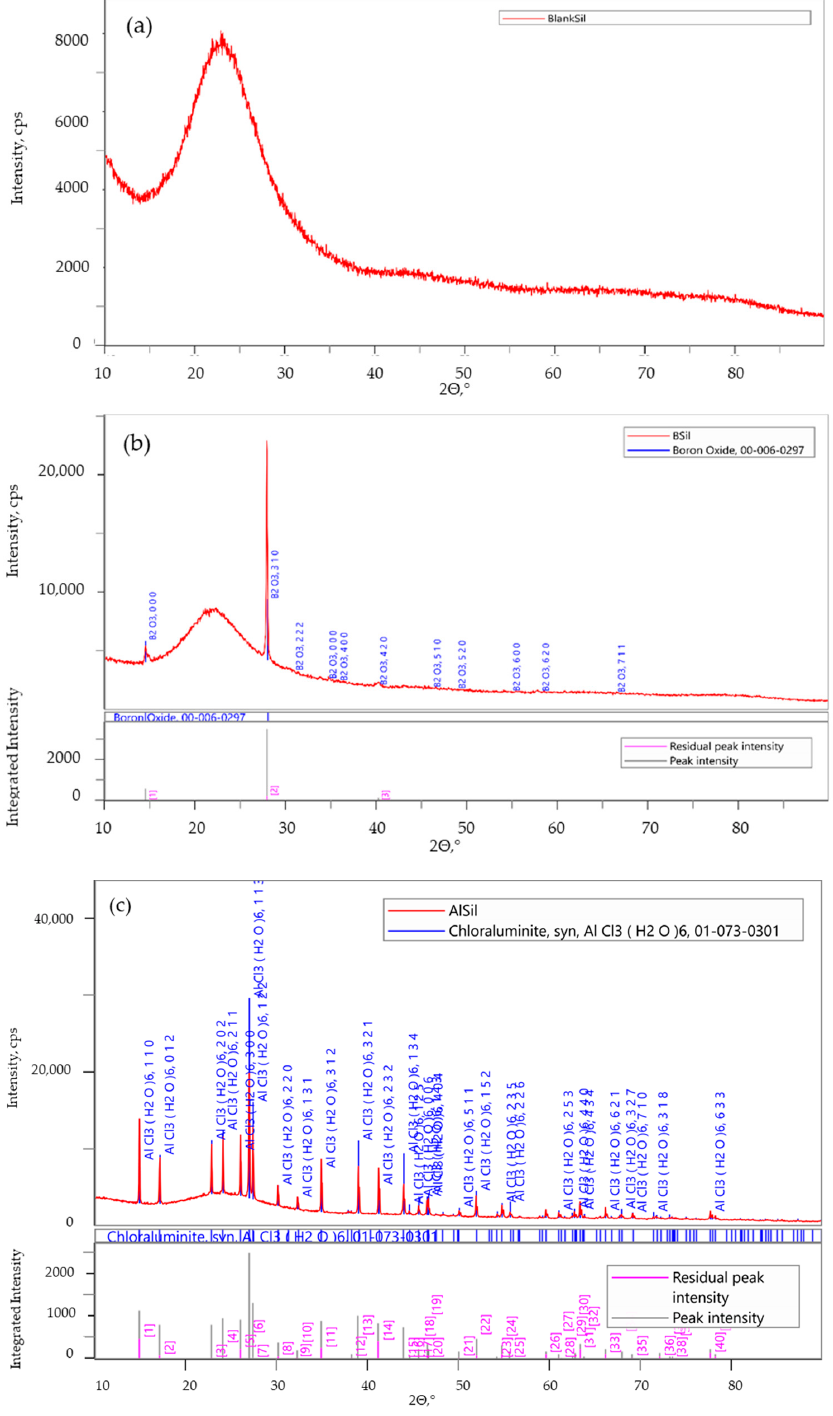
Figure 3. X-ray diffraction (XRD) analysis of the immobilized catalysts ( a ) BlankSil; ( b ) BSil and ( c ) AlSil.